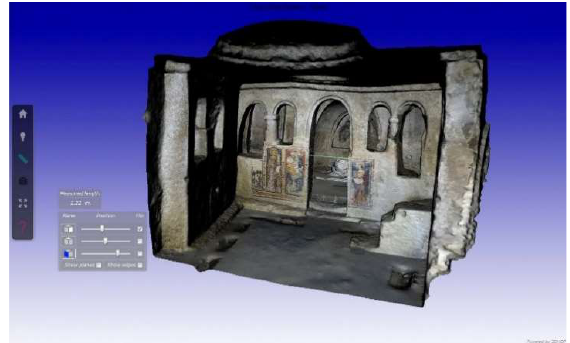
Figure 21: 3DHop Sw. Cross section with measured length (http://demo.ba.itc.cnr.it/3D/matera/chiesa-santa-barbara.html).